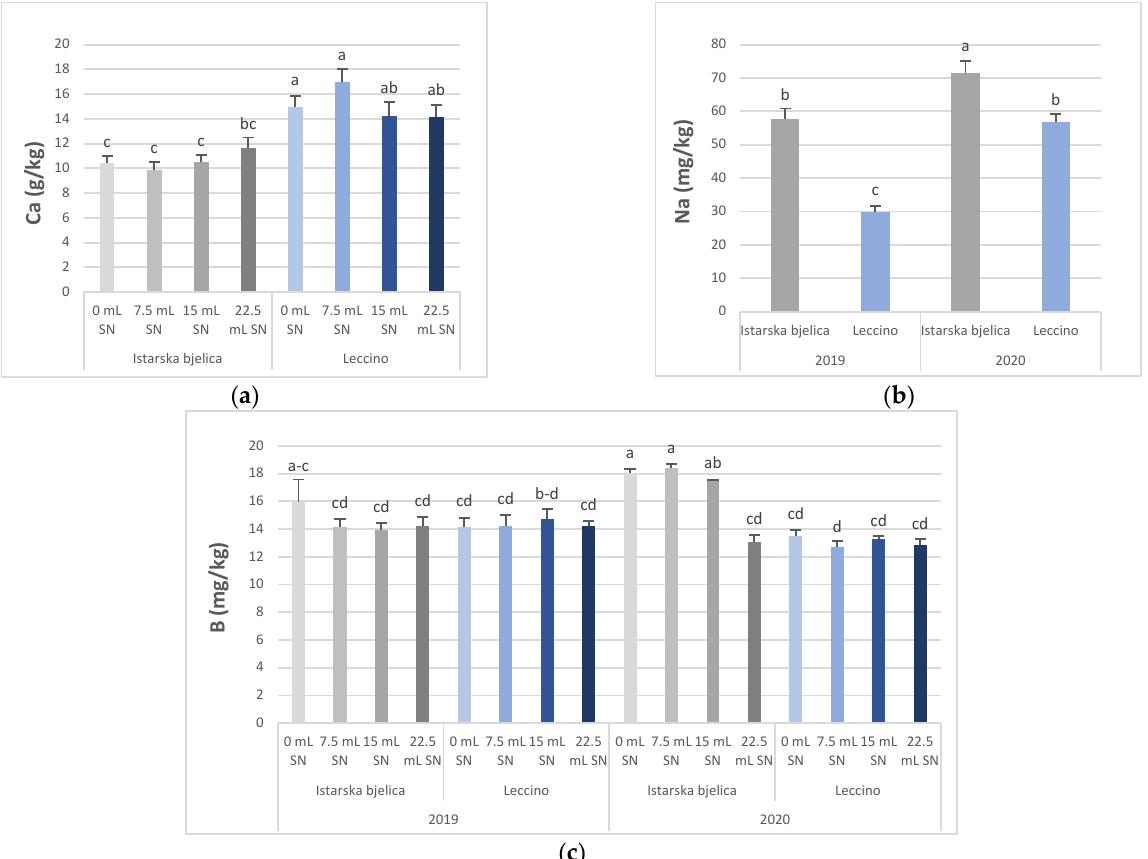
Figure 1. Multiple comparisons of the effects of ( a ) treatment (T) (0, 7.5, 15, and 22.5 mL of applied SN foliar fertilizer per 1 L of water) and cultivar (Cv.) (Istarska bjelica, Leccino) on the concentration of calcium (Ca); ( b ) cultivar, and year (Y) (2019, 2020) on the concentration of sodium (Na); and ( c ) treatment, cultivar, and year on the concentration of boron (B) in olive leaves. Different superscript lowercase letters represent statistically significant differences between the mean values at p < 0.05 that were obtained by a three-way ANOVA and Tukey’s